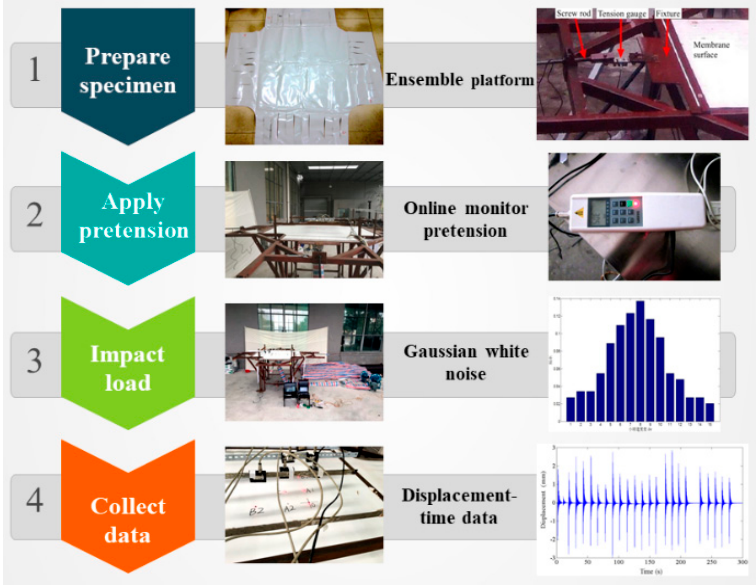
Figure 11. Flow chart of the experimental program.